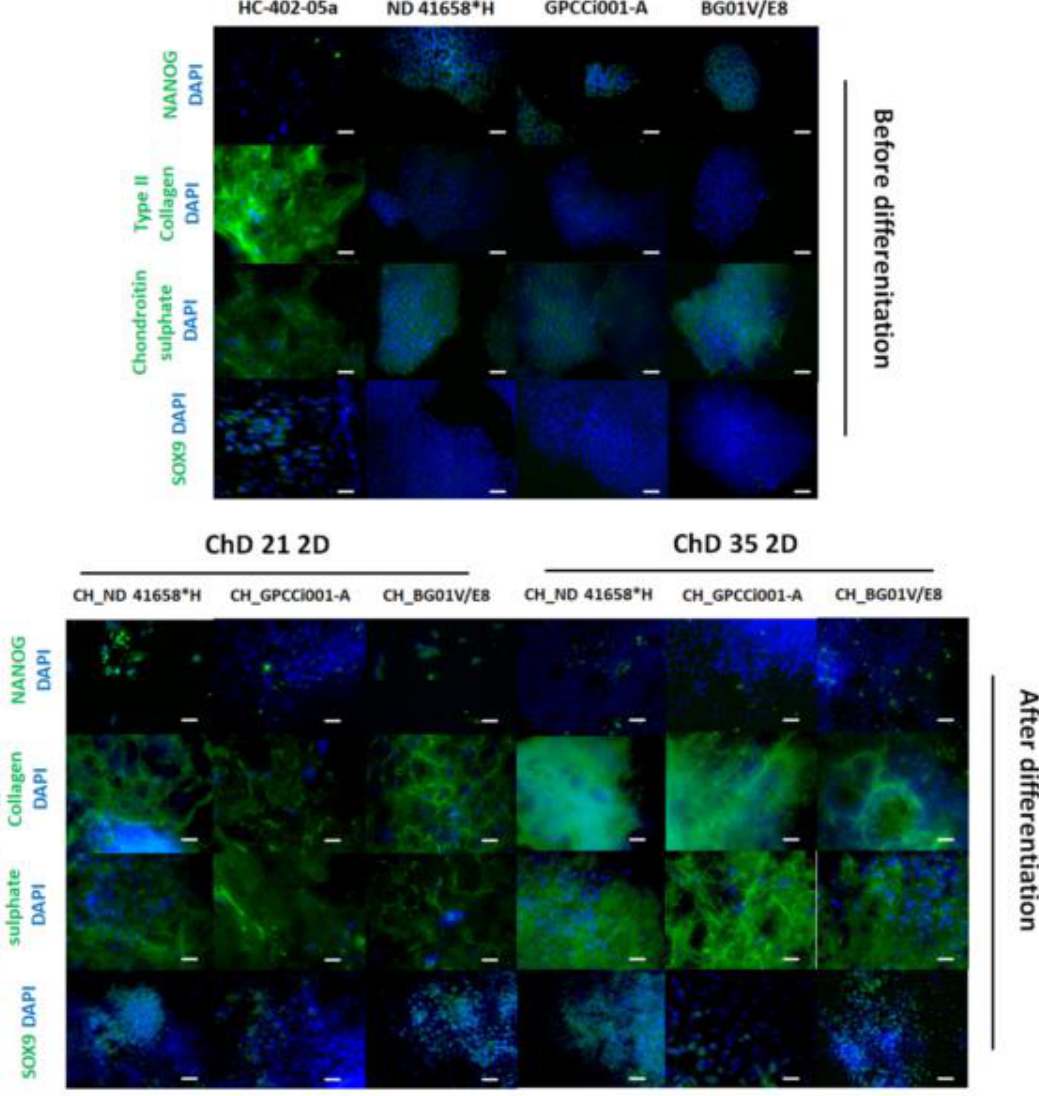
Figure 4. The prolonged chondrogenic differentiation in monolayer culture increased the production of ECM specific for chondrocytes. Differentiated EBs indicated a decreased number of pluripotent cells (NANOG) and increased distribution of ECM specific for chondrocytes (collagen type II, chondroitin sulfate). The white scale bars represent 100 μm. The blue correspond to stained nuclei with DAPI and the green represents protein of interest.